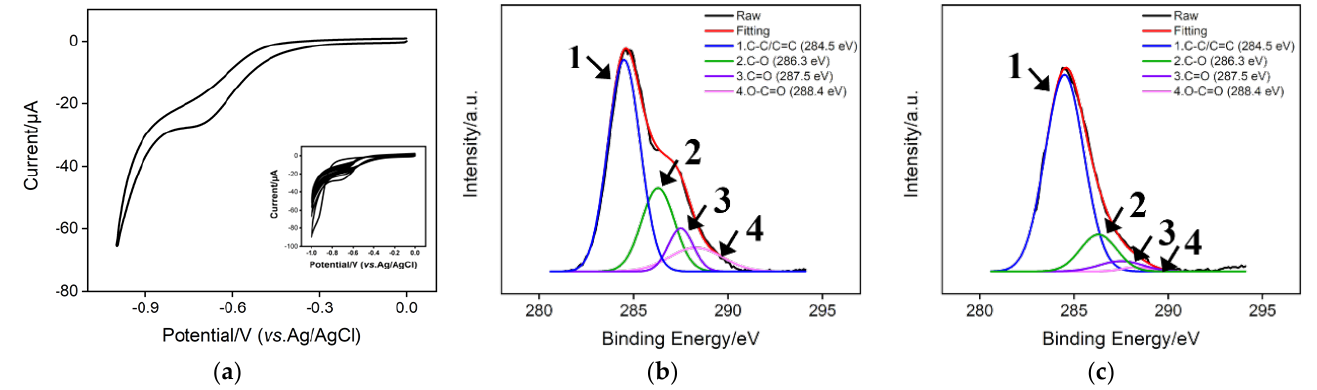
Figure 3. ( a ) CV curves of the bare ITO electrode in 0.2 M PBS (pH = 6.5) containing GO-CNT. Inset is the corresponding 30-successive CV curves. High-resolution C 1 s XPS spectra of ( b ) GO-CNT/ITO, ( c ) ErGO-CNT/ITO electrode.